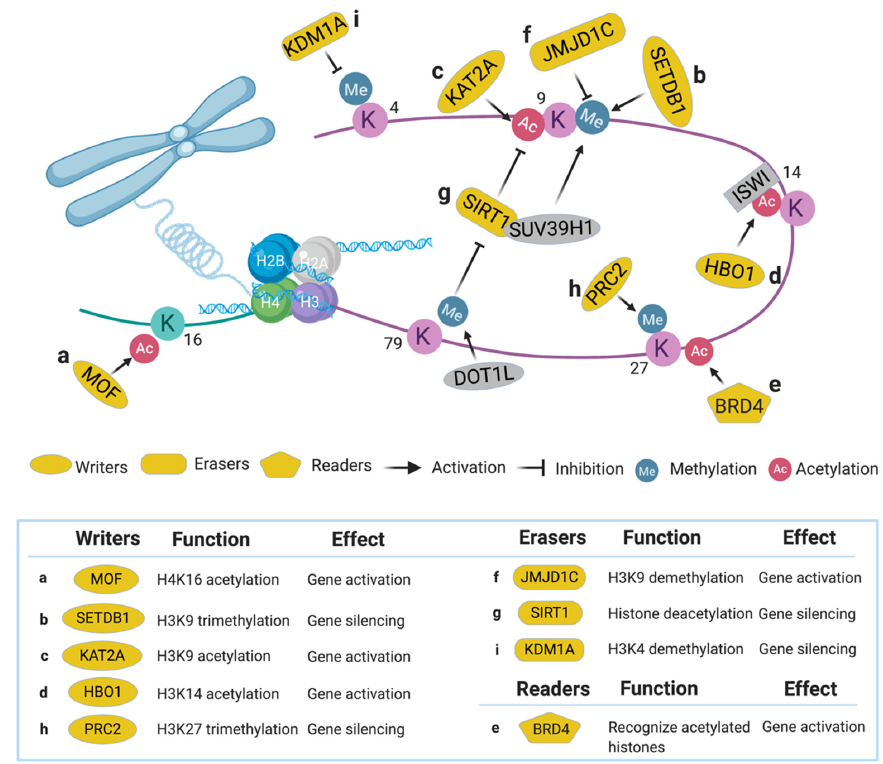
Figure 2. Epigenetic regulators identified via high-throughput genetic screens in acute myeloid leukemia (AML).